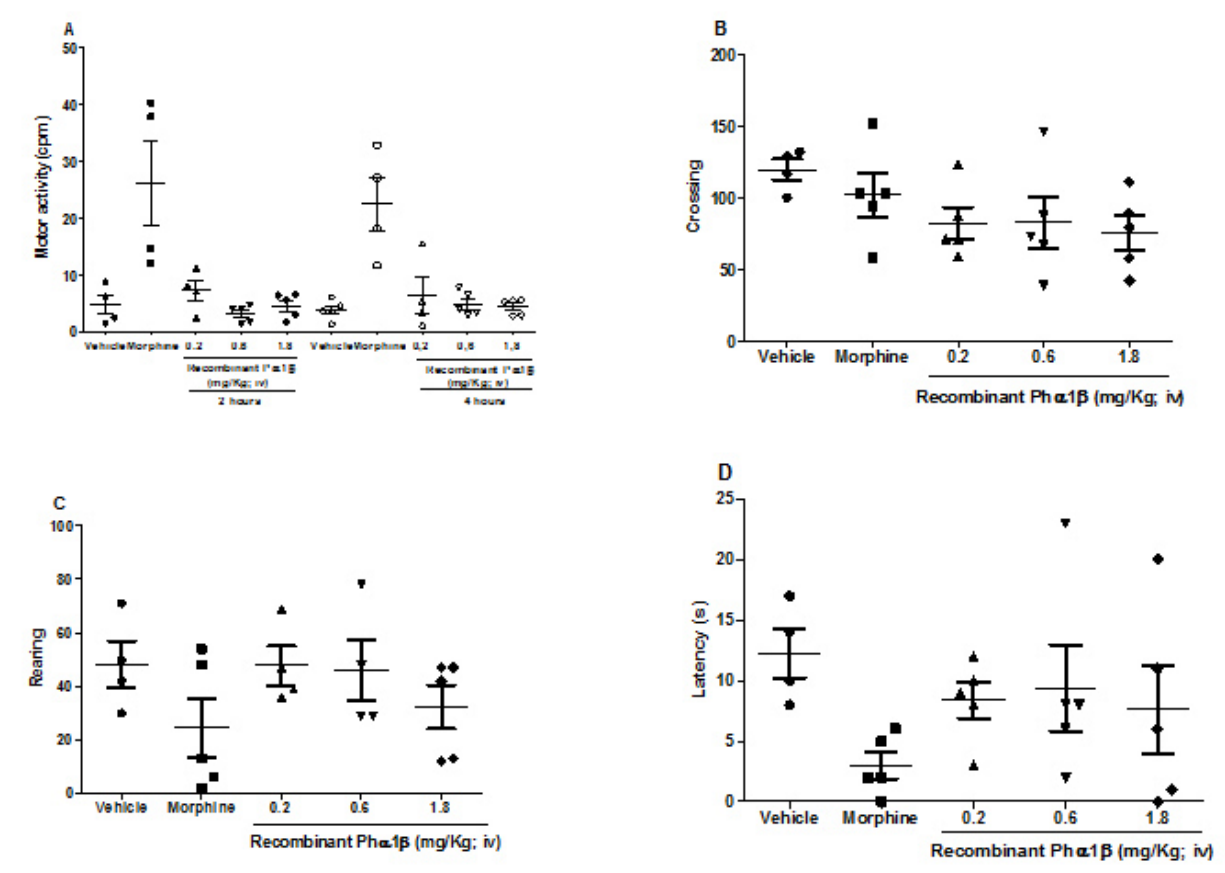
Figure 2. Effects of intravenous (i.v.) recombinant Phα1β injection on mouse motor function. (A) Spontaneous motor activity, (B) crossing, (C) rearing, and (D) latency to enter the central square in the open-field test. The individual behavioral data plotted as scatter plots and the means as a horizontal black line for